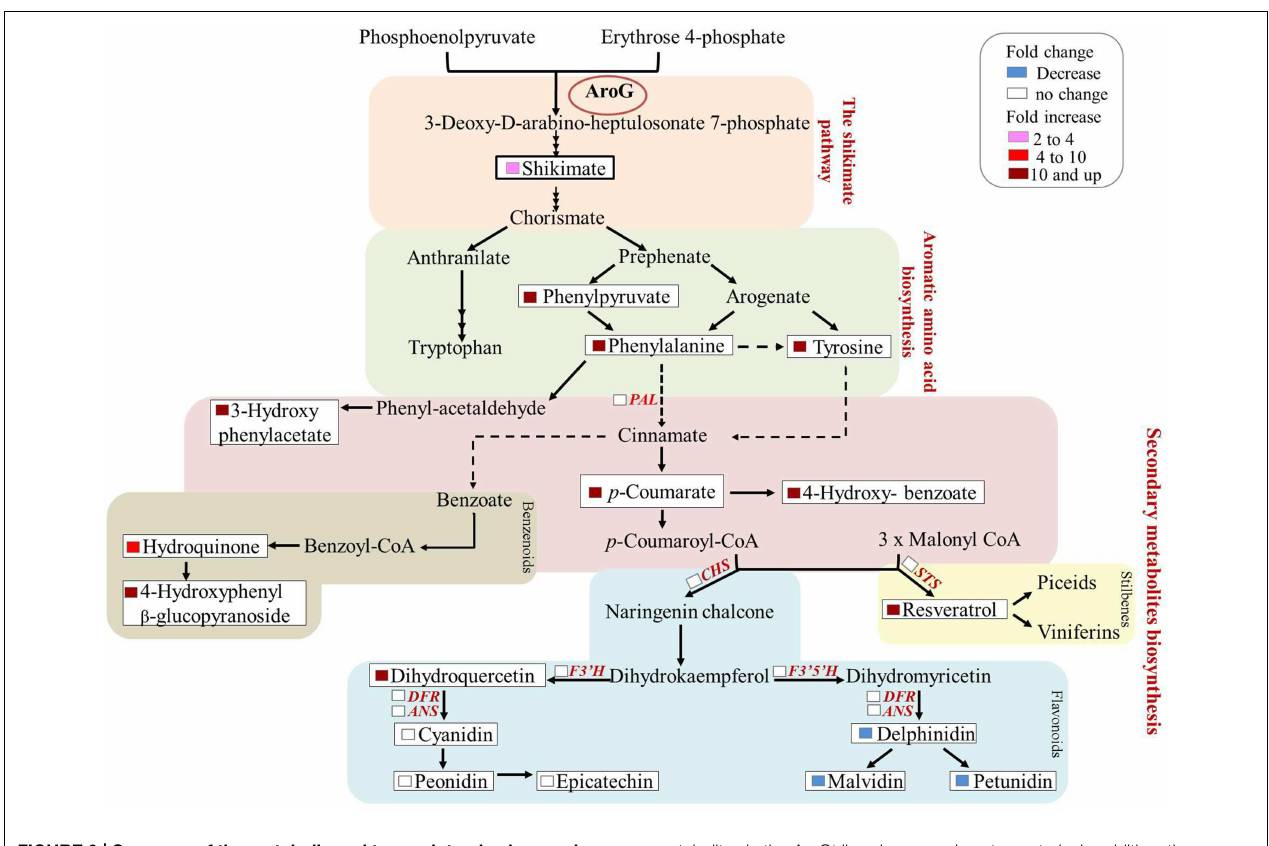
metabolites in the AroG * lines in comparison to controls. In addition, the genes whose transcript levels were determined in line 13 are marked in red. None of these transcripts showed significant